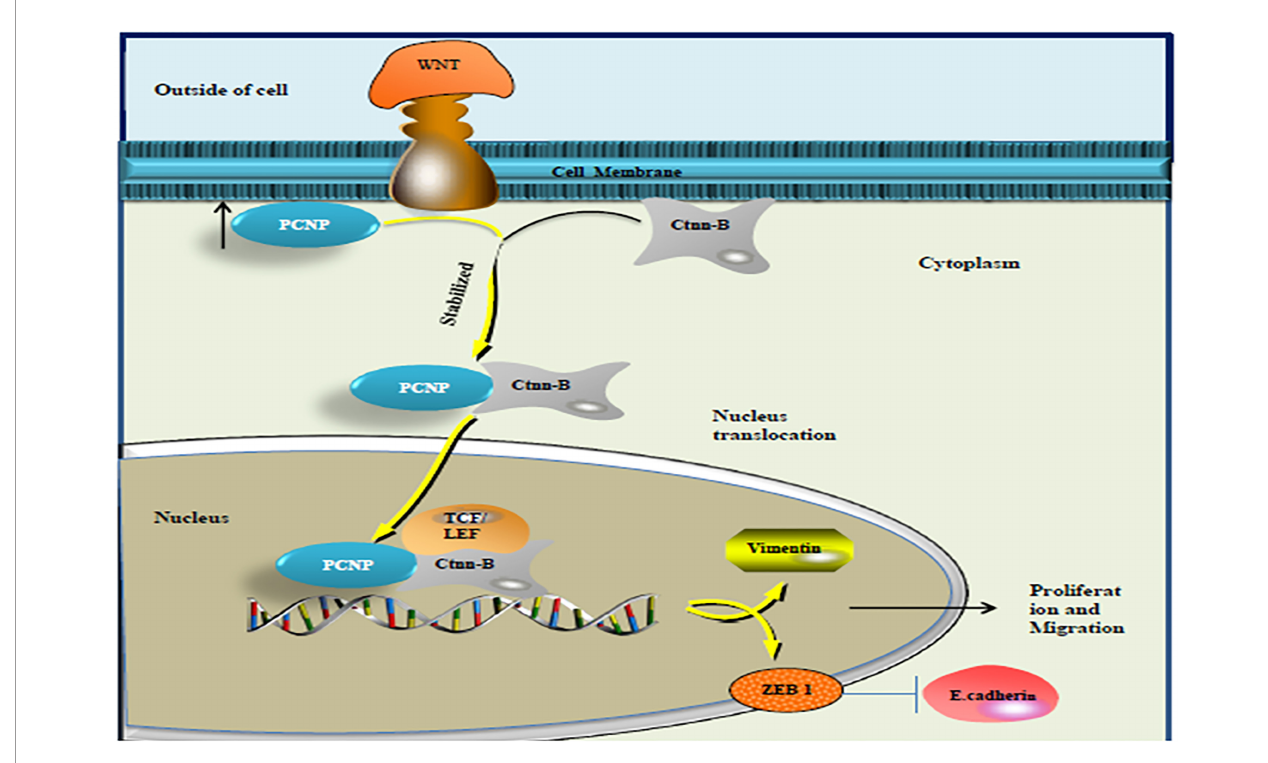
FIGURE 2 | PCNP binding with b catenin: after binding with b catenin, PCNP becomes stabilized and accelerates the expression of b catenin in the nucleus, which further activates the Wnt signaling pathway and promotes ovarian cancer